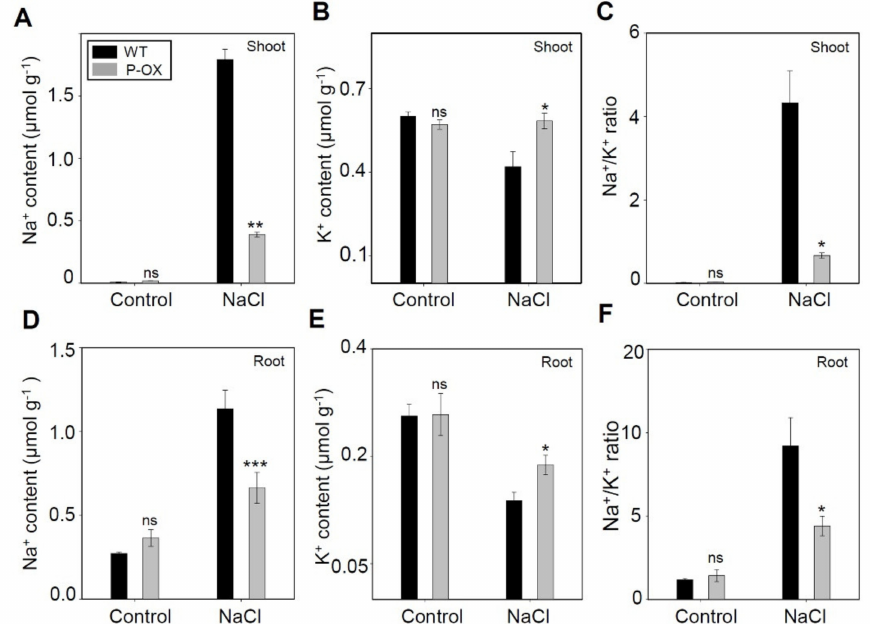
Figure 5. Accumulation of Na + and K + in wild-type and transgenic rice plants under salt stress. Na +